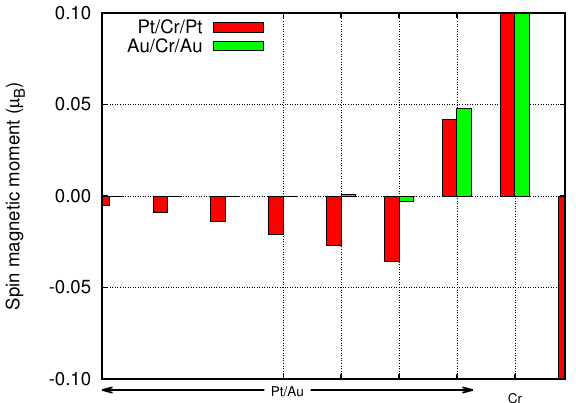
Figure 3. Spin magnetic moments at the first metal atoms at the Pt/Cr and Au/Cr interfaces.